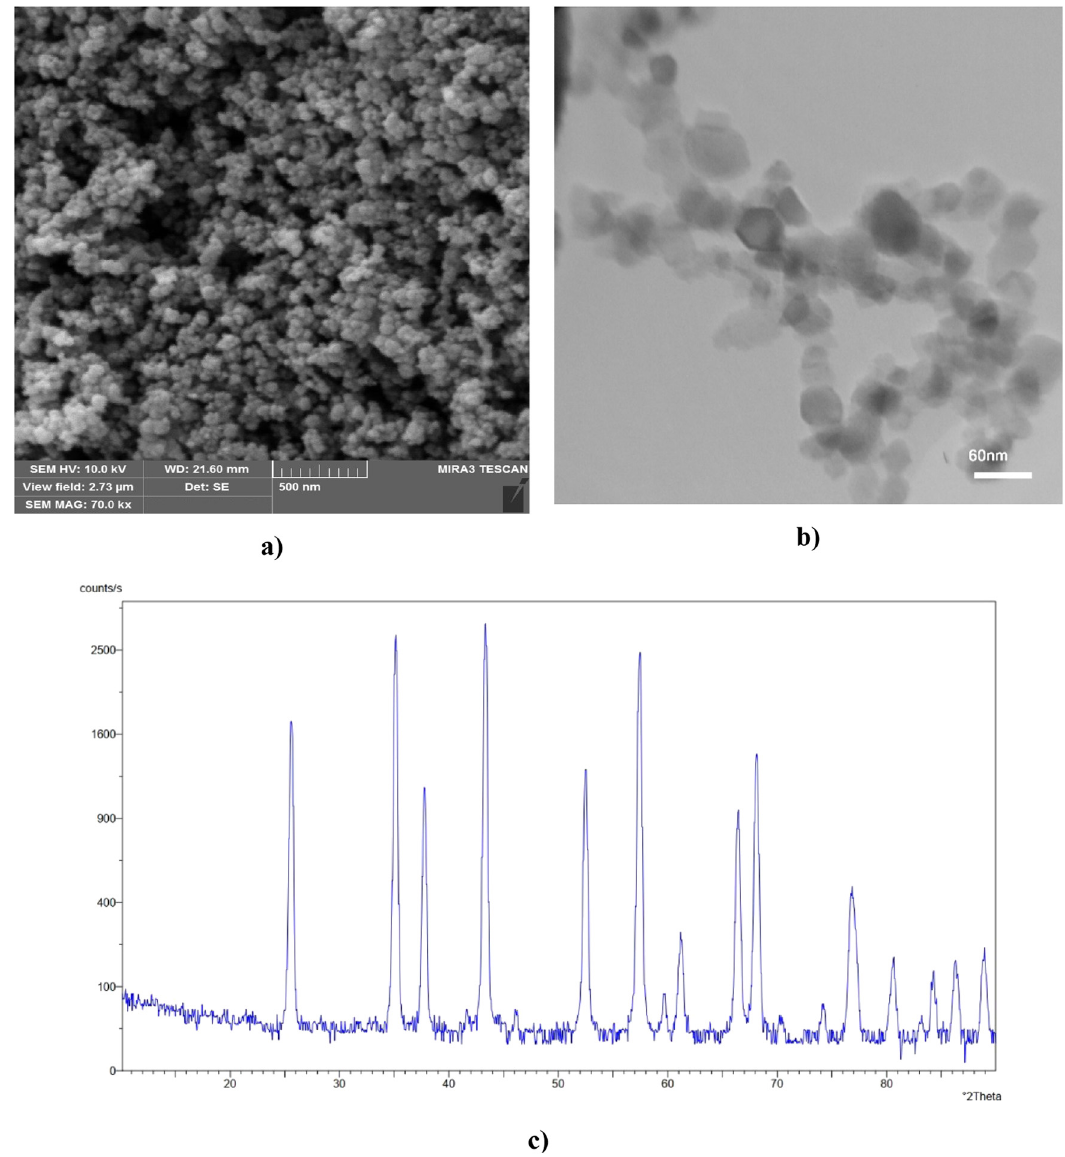
Figure 1: Characterization of the employed Al 2 O 3 NPs: ( a ) SEM image, ( b ) TEM image, and ( c ) XRD